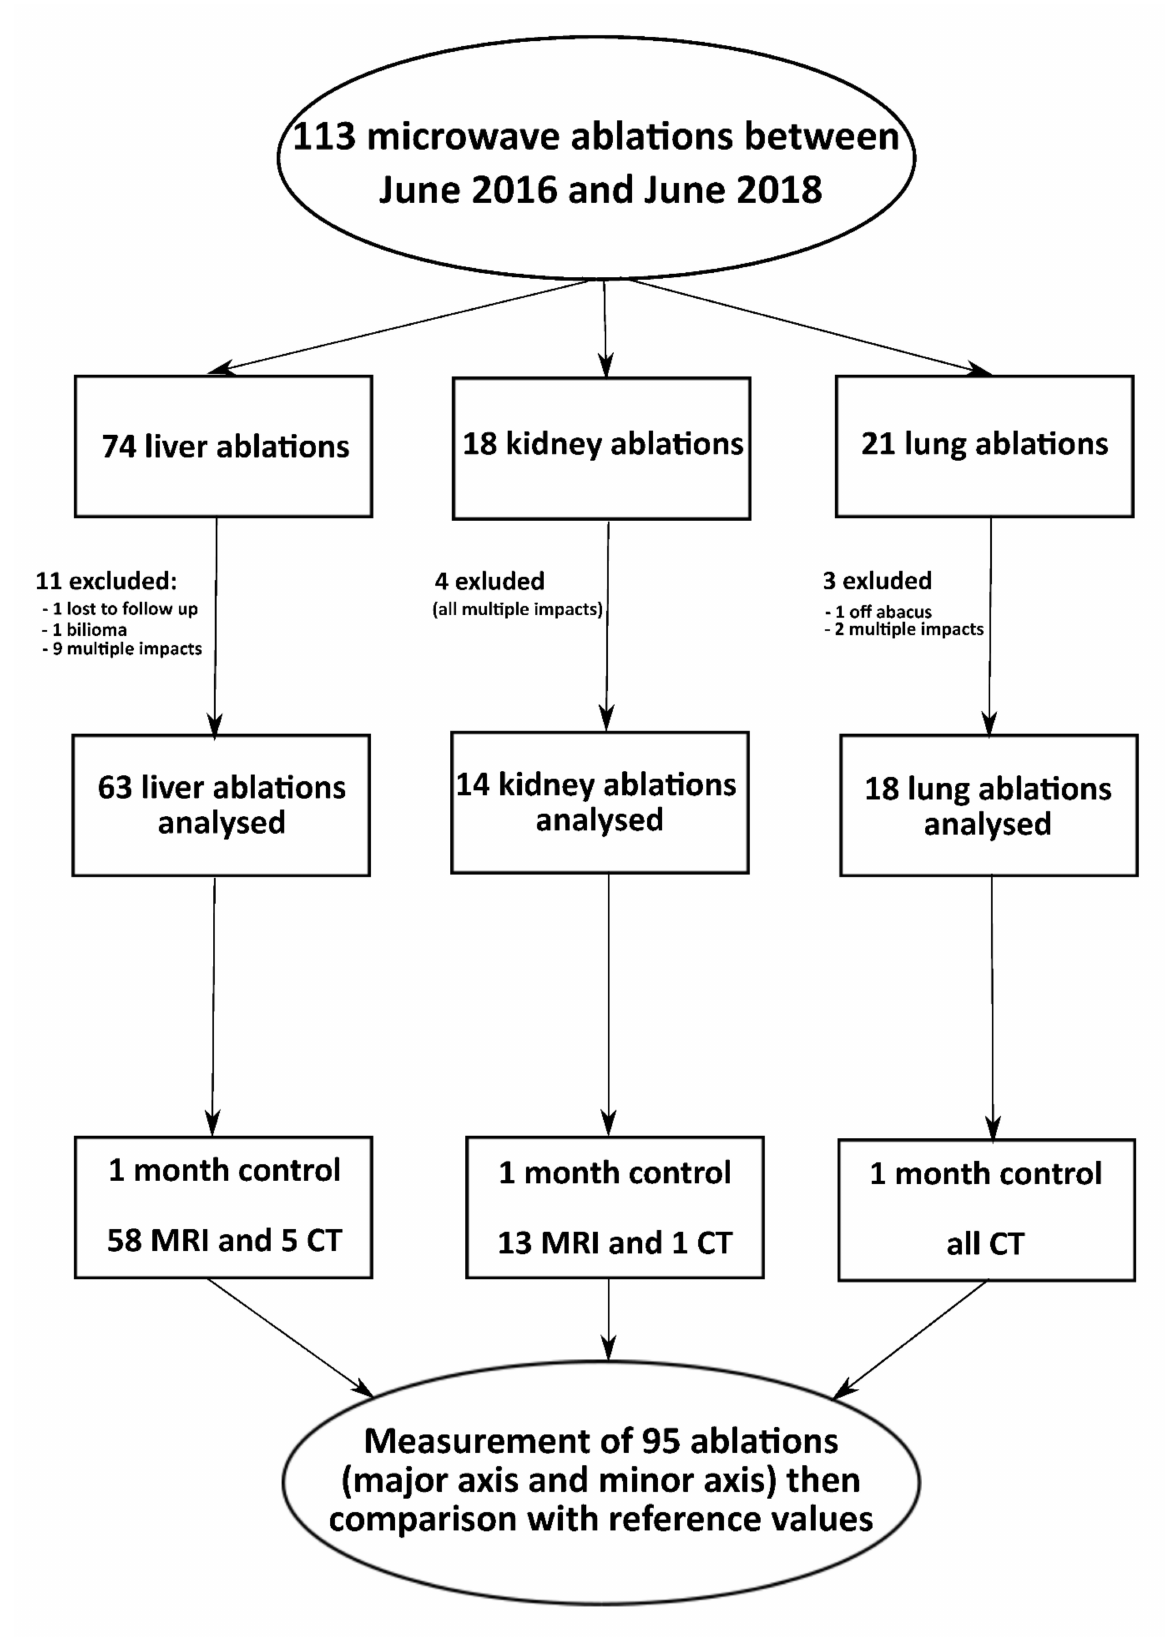
Figure 1. Flowchart of the